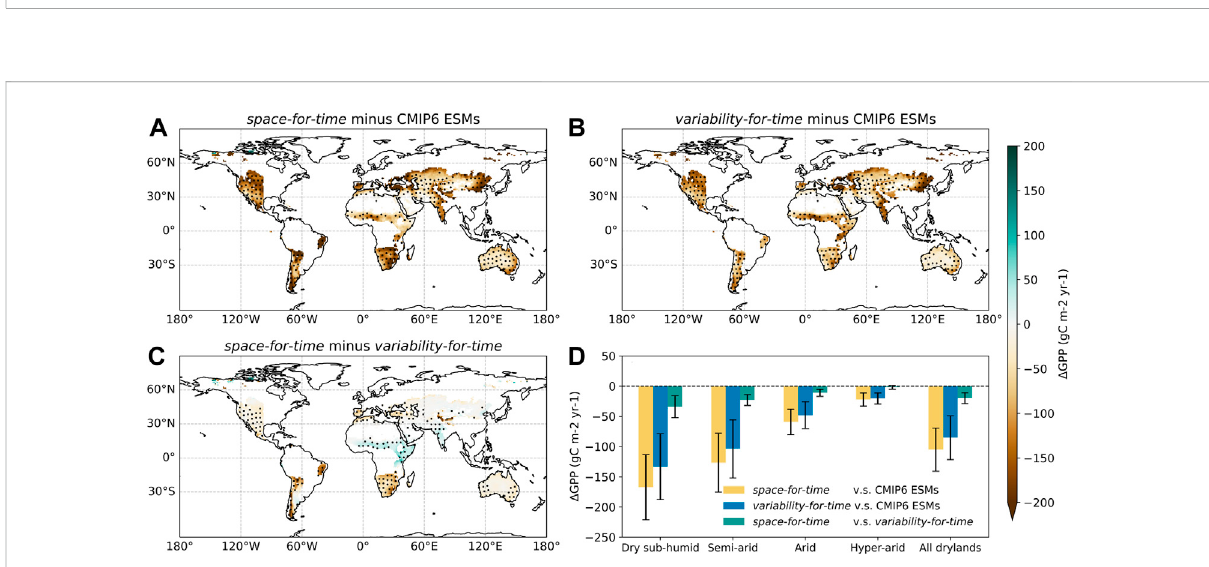
FIGURE 3 The differences in projected future GPP changes (during 2081 – 2100) among the three approaches. (A) The difference betweenthe space-for- time approach and original CMIP6 ESM projections. (B) The difference between the variability-for-time approach and original CMIP6 ESM projections. (C) The difference between the space-for-time approach and variability-for-time approach. The black dots in (A – C) denote regions where more than 80% ESMs show the same sign as the multi-model ensemble mean. (D) the differences in GPP estimates aggregated over different dryland subcategories, with error bars denoting the ±1 standard deviation among